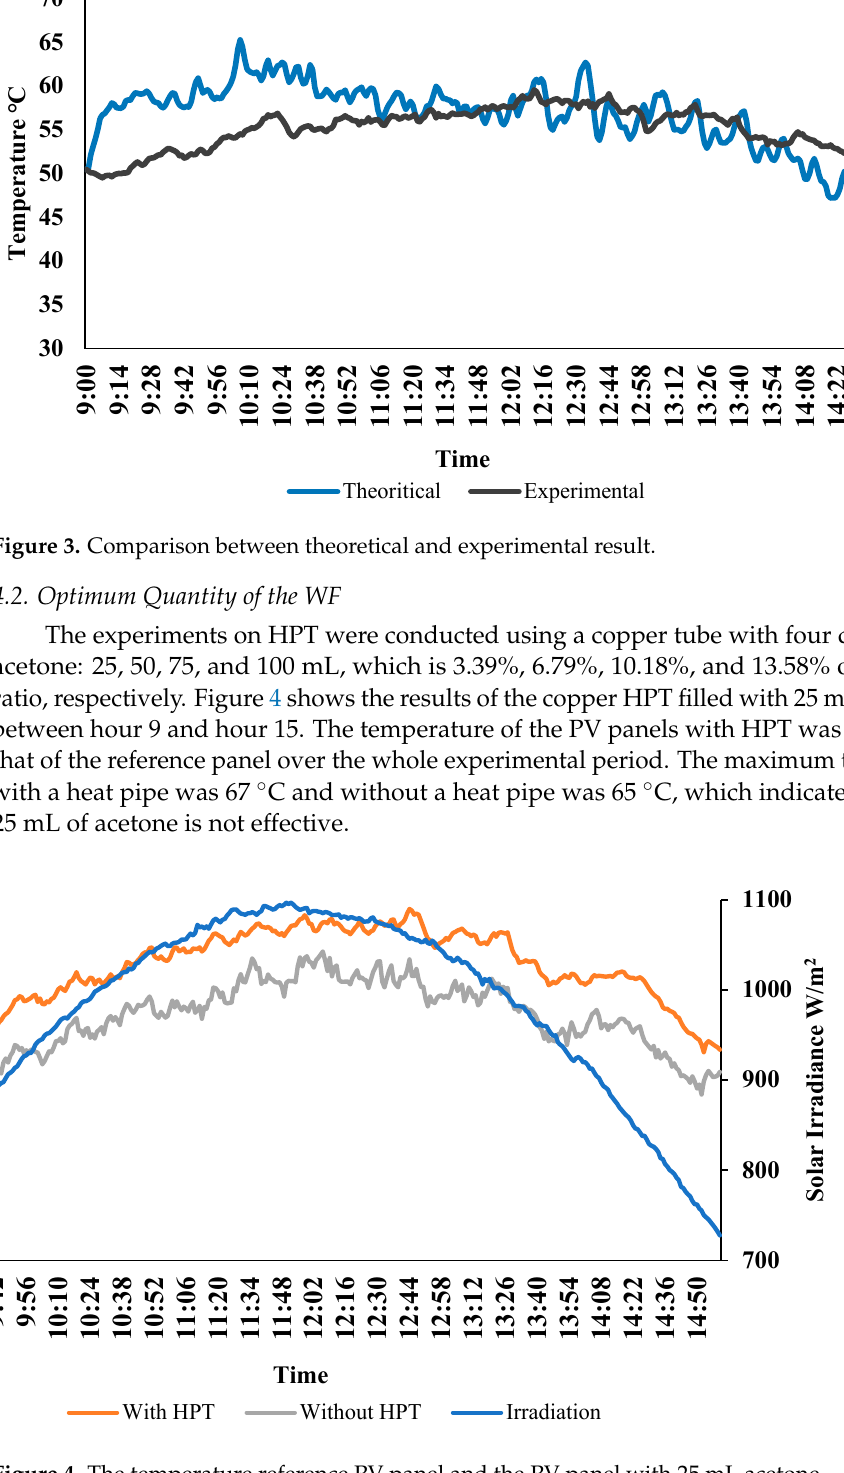
Figure 4. The temperature reference PV panel and the PV panel with 25 mL acetone.